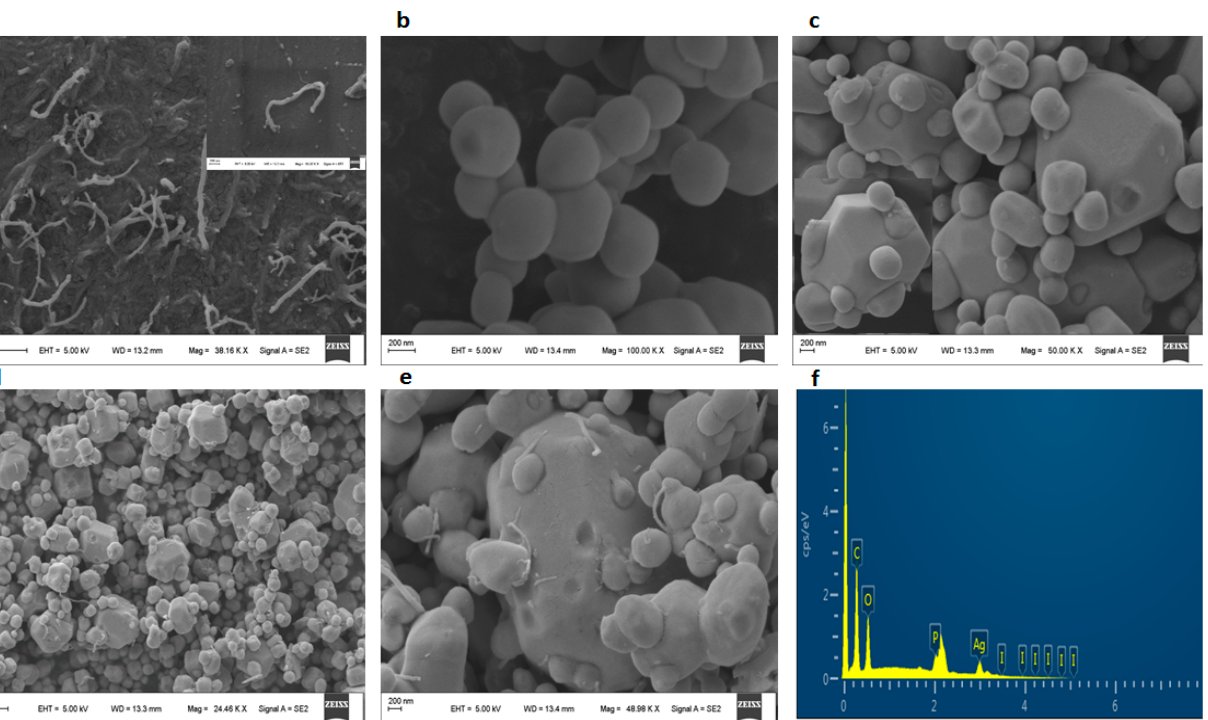
Figure 4. ( a ) DRS spectra of the synthesized materials, and ( b ) the plot of ( α h ʋ ) 2 versus energy (h ʋ ). 2.2.5. Electrochemical Impedance Spectroscopy The electron–hole recombination resistance and the charge transfer ability ofthe synthesized photocatalysts were measured using electrochemical impedance spectros- copy (EIS). As shown in Figure 5, the diameters of the arc followed the order CNT-COO − /Ag 3 PO 4 @AgIO 4 <CNT-Ag 3 PO 4 @AgIO 4 < Ag 3 PO 4 @AgIO 4 < Ag 3 PO 4 . Therefore, it can be confirmed that CNT-COO − /Ag 3 PO 4 @AgIO 4 exhibited enhanced e − /h + separation and transferability at the catalyst–electrolyte interface compared with the other compo- sites. In addition, the good interaction between the CNT-COO and Ag 3 PO 4 in the CNT-COO/Ag 3 PO 4 @AgIO 4 composite further enhanced the electron transfer over the CNT-Ag 3 PO 4 @AgIO 4 , which was due to the interfacial bonding between the CNT-COO